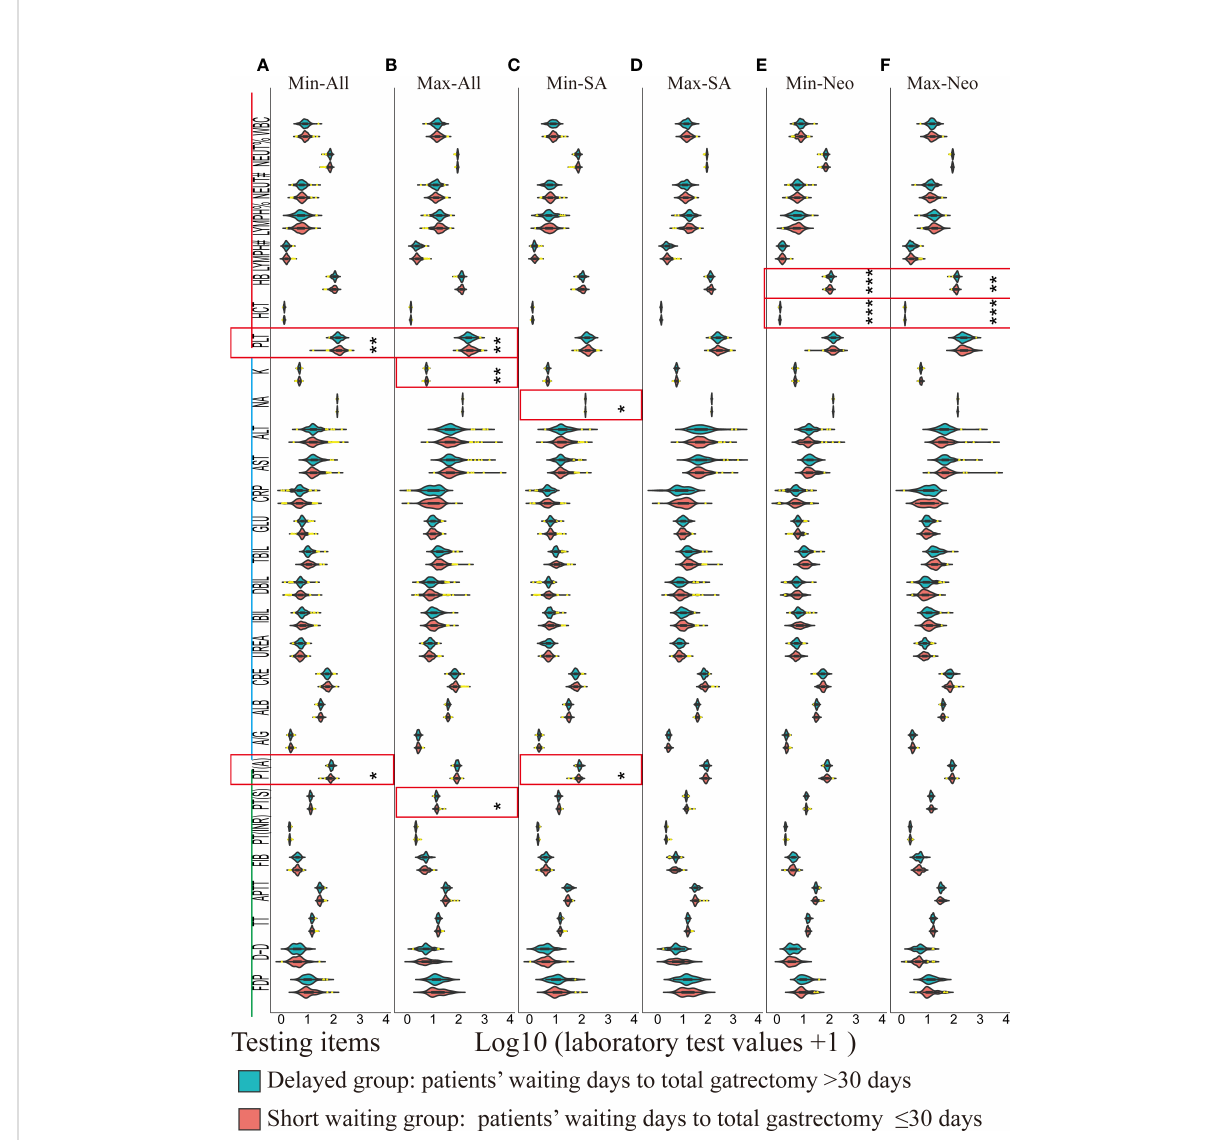
FIGURE 3 A violin plot of the laboratory test results of routine blood test (red), biochemical tests (blue), and coagulation tests (green) between the delayed (blue green) and the short waiting groups (light red). Laboratory values of outliers (1.5 times greater than or less than the interquartile range) were marked in yellow. Signi fi cantly different items between the delayed and the short waiting groups were marked in red rectangles. * p < 0.05, ** p < 0.01, *** p < 0.001. Min: Minimal postoperative laboratory values. Min: Maximal postoperative laboratory values. SA: Surgery alone, Neo: Neoadjuvant therapy plus surgery. WBC: Leukocyte count; NEUT%: Percentage of neutrophils; NEUT#: Absolute Neutrophil count; LYMPH %: Percentage of lymphocytes; LYMPH#: Lymphocyte absolute count; HB: Hemoglobin; HCT: Hematocrit; PLT: platelet count; K: Potassium; NA: Sodium; ALT: Alanine aminotransferase; AST: Aspartate aminotransferase; CRP: C-reactive protein; GLU: Blood sugar; TBIL: Total bilirubin; DBIL: Direct (conjugated) bilirubin; IBIL: Indirect (free) bilirubin; UREA: Urea; CRE: Creatinine; ALB: albumin; A/G: Albumin/globulin ratio; PT(A): Plasma prothrombin activity; PT(S): Plasma prothrombin time; PT(INR): International normalized ratio of prothrombin time; FIB: Fibrinogen; APTT: Activated partial thromboplastin time; TT: Thrombin time; D-D: Plasma D-dimer; FDP: Fibrinogen degradation products; (A) Violin plots of minimal postoperative laboratory results of all patients between the delayed and short waiting groups. (B) Violin plots of maximal postoperative laboratory results of all patients between the delayed and short waiting groups. (C) Violin plots of minimal postoperative laboratory results of SA patients between the delayed and short waiting groups. (D) Violin plots of maximal postoperative laboratory results of SA patients between the delayed and short waiting groups. (E) Violin plots of minimal postoperative laboratory results of the neoadjuvant patients between the delayed and short waiting groups. (F) Violin plots of maximal postoperative laboratory results of the neoadjuvant patients between the delayed and short waiting